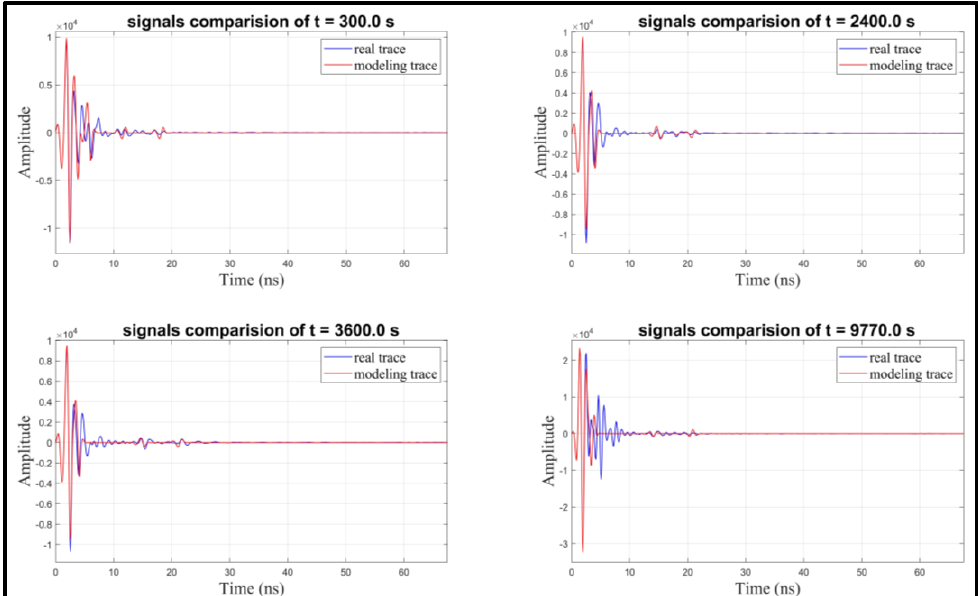
Figure 14. A comparison of the fit between the forward modeling and real GPR traces at four different injection times (Author’s own work) [56].